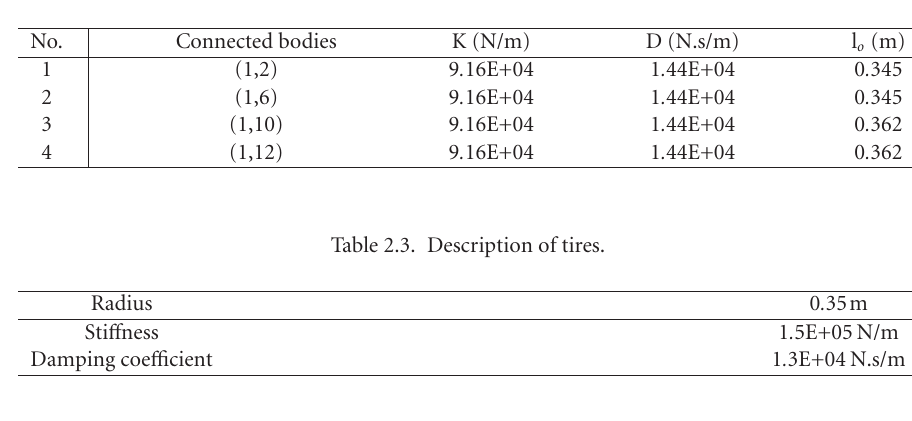
Table 2.2. Description of springs and dampers.